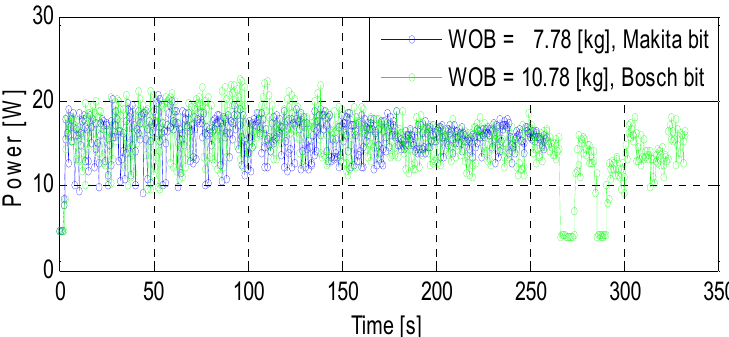
Figure 7. Power consumption during drillability test performed for Szydłowiec sandstone A—soft sample with motor’s power supply voltage 24 V, Makita and Bosch coring bits, weight on bit (WOB) 76.32 N and 105.75 N, respectively.